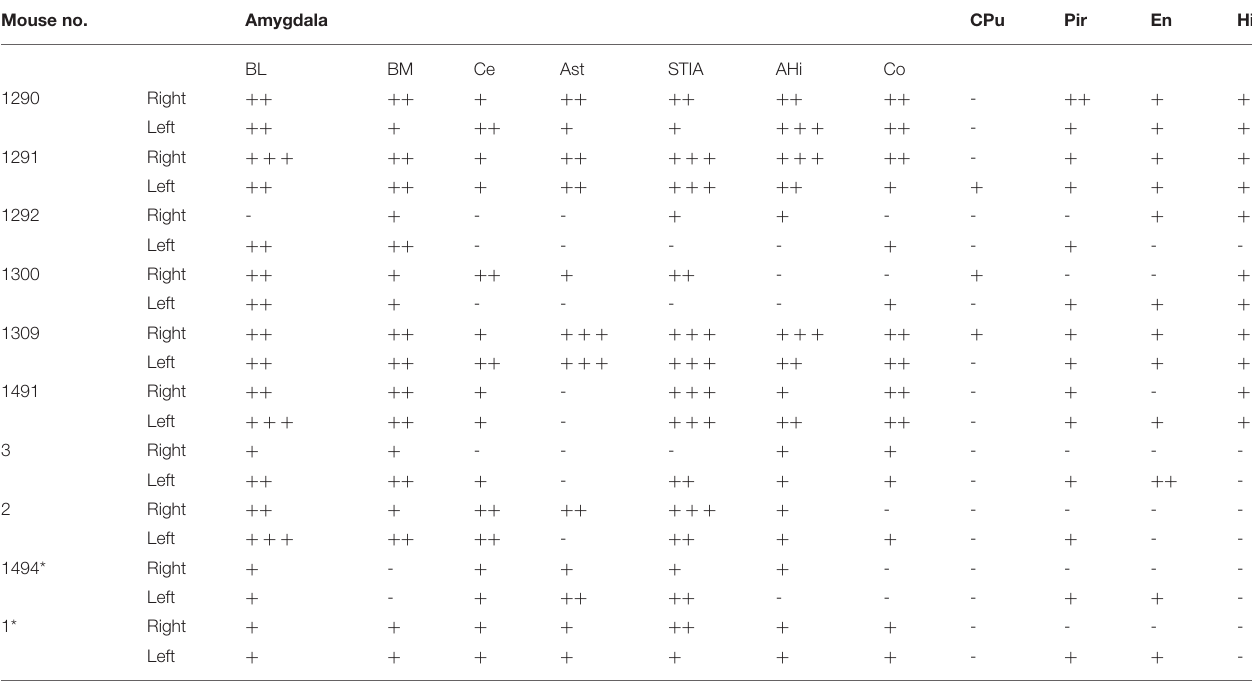
TABLE 2 | Lesion extent induced by the ibotenic acid injection into the bilateral amygdala. Mouse